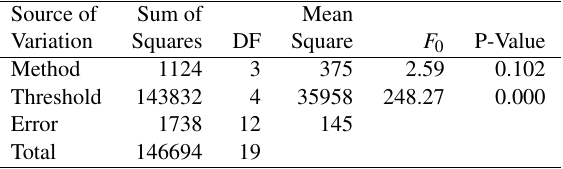
Table 6. ANOVA for DAP-TR (threshold is